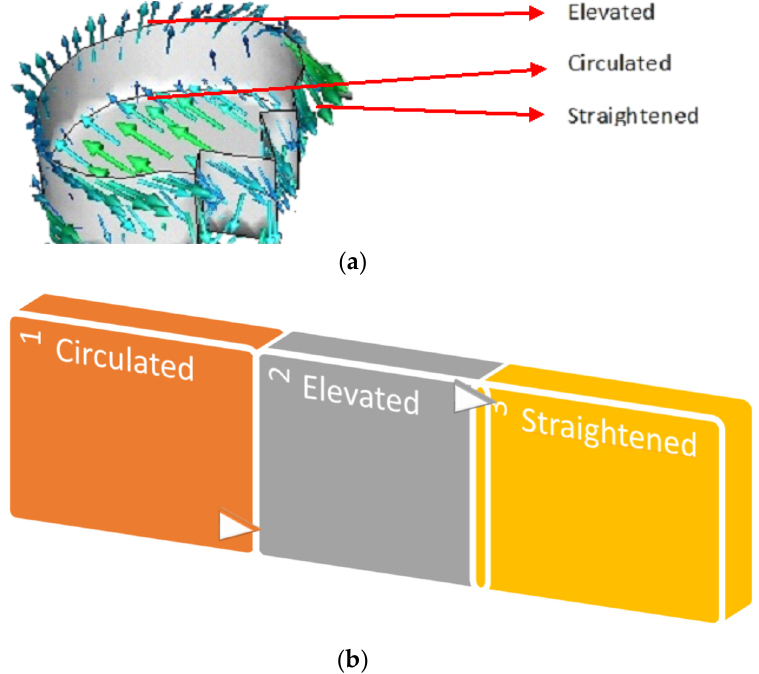
Figure 5. Fluid interaction. ( a ) Velocity vectors within the pattern. ( b ) Fluid flow sequence.